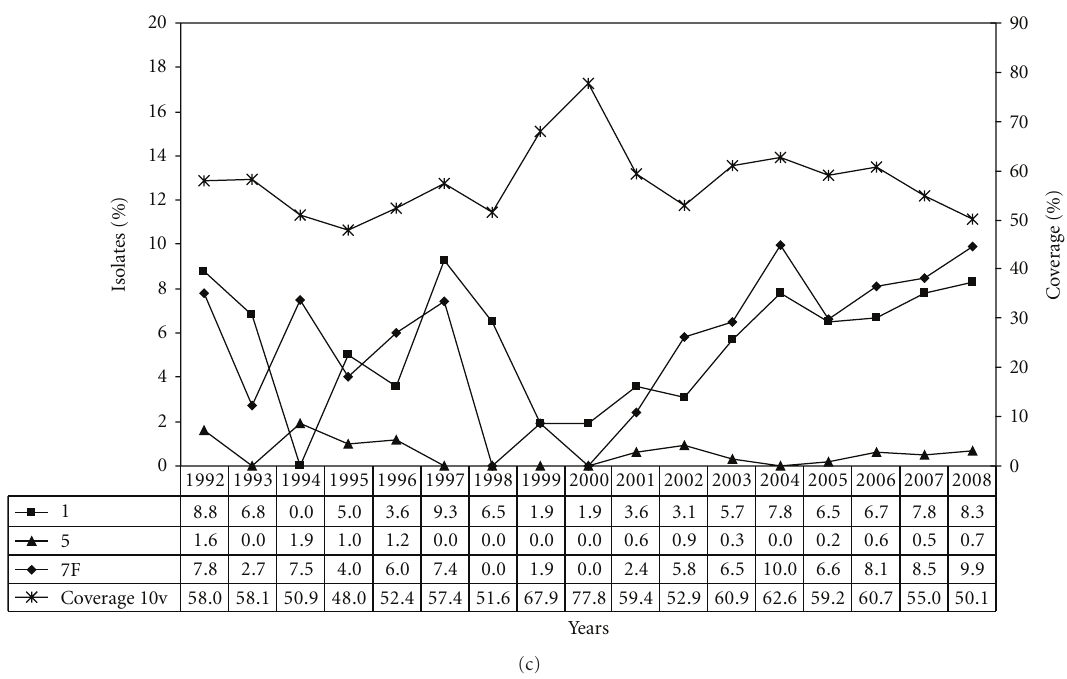
Figure 3: (a) Distribution of the additional 10v-pneumococcal conjugate vaccine serotypes 1, 5, and 7F and the 10-valent vaccine coverage in percent (1992–2008, n = 9,394). (b) Distribution of the additional 10v-pneumococcal conjugate vaccine serotypes 1, 5, and 7F and the 10-valent vaccine coverage among children in percent (1992–2008, n = 2,948). (c) Distribution of the additional 10v-pneumococcal conjugate vaccine serotypes 1, 5, and 7F and the 10-valent vaccine coverage among adults in percent (1992–2008, n =